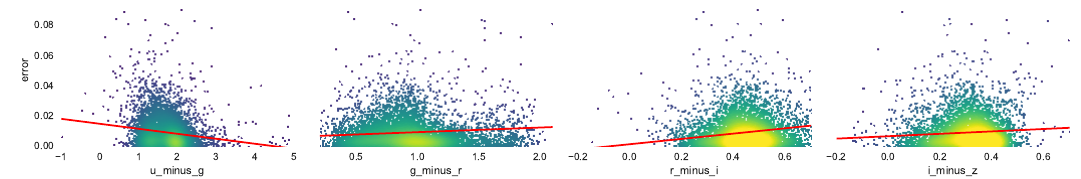
Figure 6. Absolute error when using the Random Forest classifier and different color ranges.